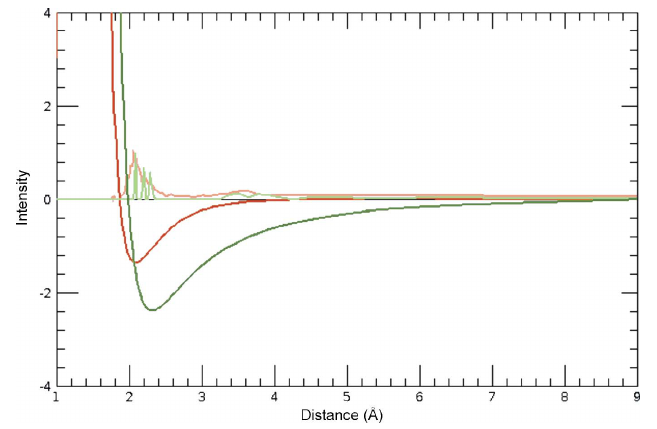
Figure 4 Radial distribution functions (light green and light red) and calculated effective intermolecular potentials of N—H/NC (red) and N—D/NC (green)